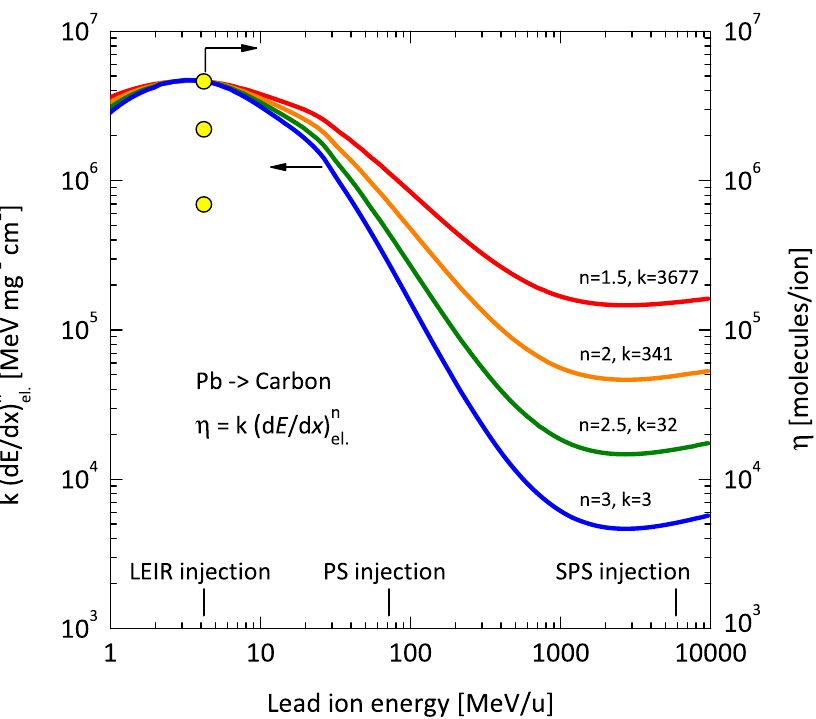
FIG. 8. Electronic energy loss ð dE=dx Þ n of lead ions impacting onto a carbon target (solid lines), calculated with SRIM as a function el of ion energy and parameter n . The measured desorption yields (points) of the unbaked and baked amorphous carbon coated vacuum chambers, tested at 4 : 2 MeV = u , are also shown. The dE=dx curves are normalized to the highest desorption yield of (cid:1) ¼ 4 : 6 (cid:2) 10 6 molecules = ion , measured for the unbaked amorphous carbon film. The ion injection energies into LEIR, PS, and SPS are indicated.